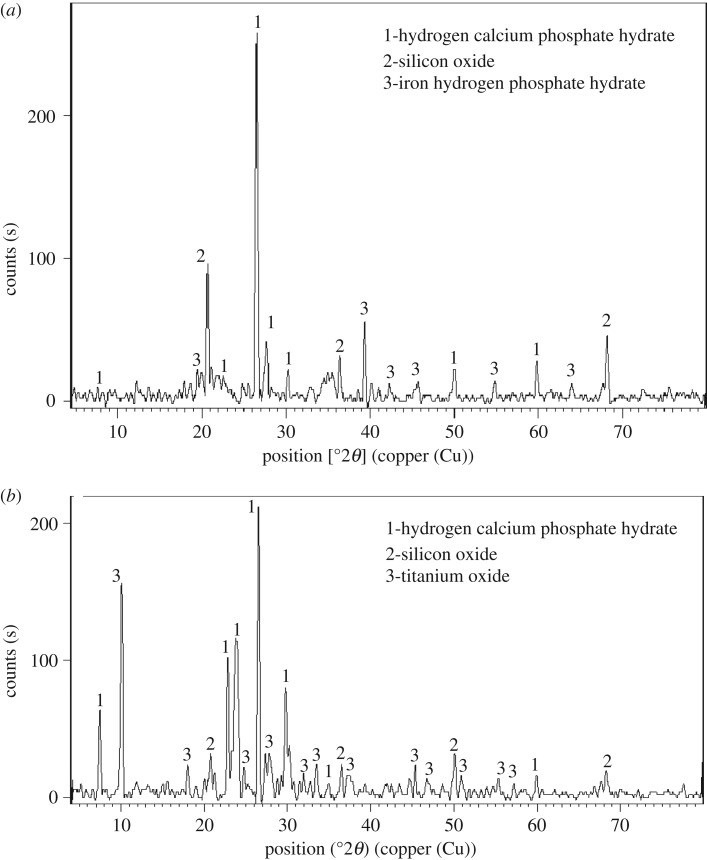
(a) XRD pattern of ASS adsorbent, (b) XRD pattern of TiO2/ASS (1 : 2) nanocomposite.